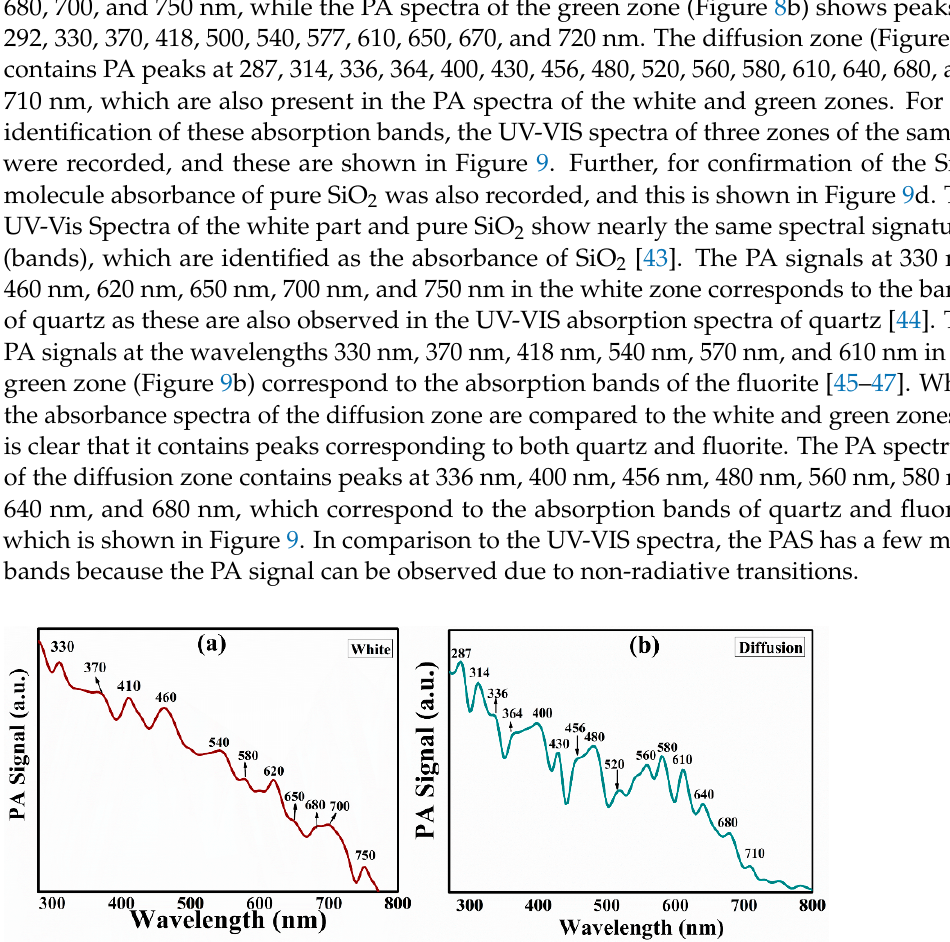
Figure 9. UV-VIS spectra of quartz-fluorite sample recorded for ( a ) white zone, ( b ) diffusion zone, ( c ) green zone, ( d ) and pure SiO 2 sample (CDH, New Delhi, 99.9% pure). 2.5. Chemometric Methods Principal Component Analysis of LIBS Data Principal Component Analysis (PCA) is a simple but influential multivariate tech- nique that can be employed together with other spectroscopic data to classify a large num- ber of samples. In this work, PCA very proficiently divides the LIBS data of the sample into three clusters (groups), indicating that the sample has three regions/zones with dif- ferent mineral compositions. Seventeen spectra of each zone were used to construct the